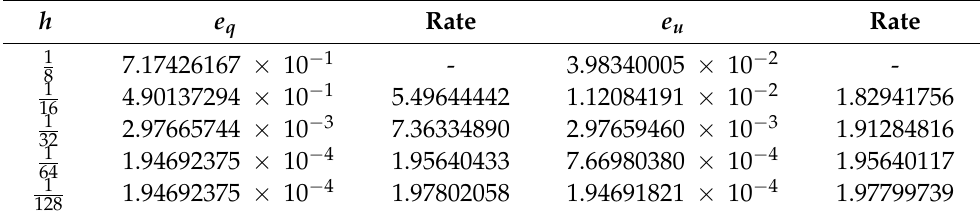
Table 9. Error e q and e u for the spatial convergence rates with α = 0.7.